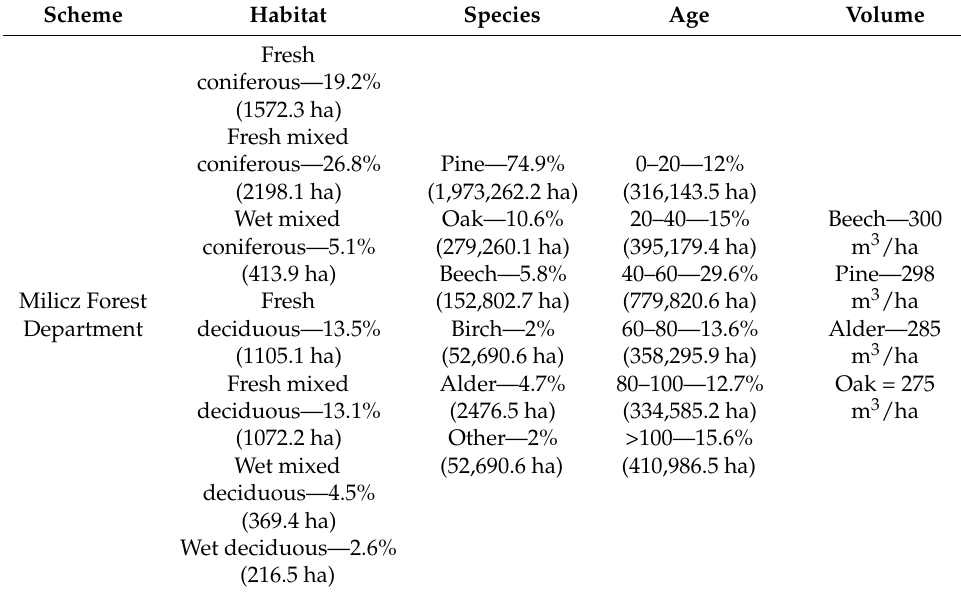
Table 3. Characteristics of stands in the research